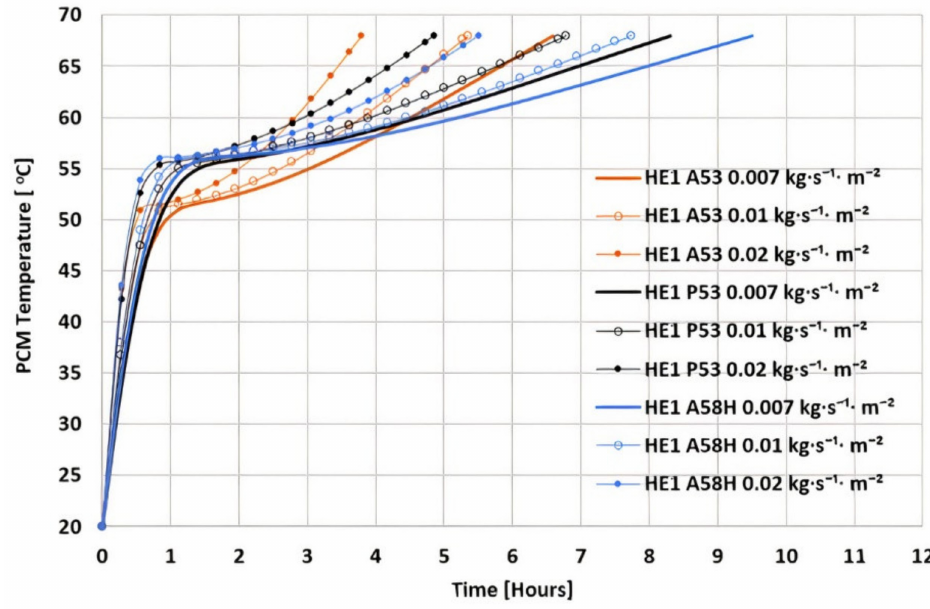
Figure 9. Area average temperature of PCM active volume during charging for all PCMs and all HTF flow rates studied, for